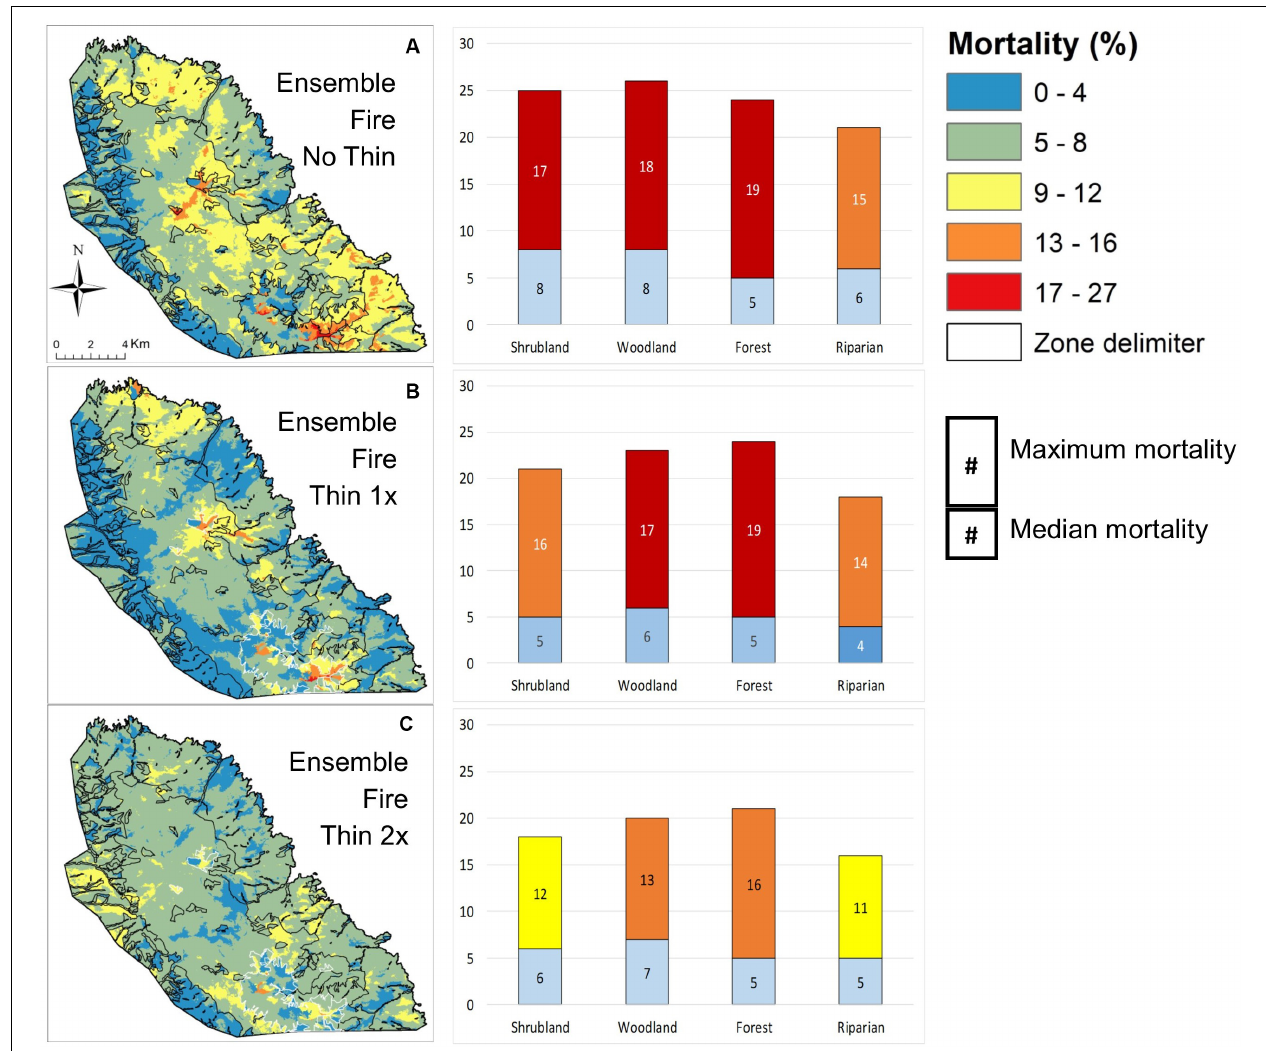
FIGURE 8 | Effects of thinning treatments on fire-caused mortality under projected climate ensemble conditions. Maps depict median decadal mortality rate within the study area under scenarios of no thinning (A) , single-entry thinning (B) , and double-entry thinning (C) . Histograms display median and maximum mortality rates within shrubland, woodland, forest, and riparian vegetation